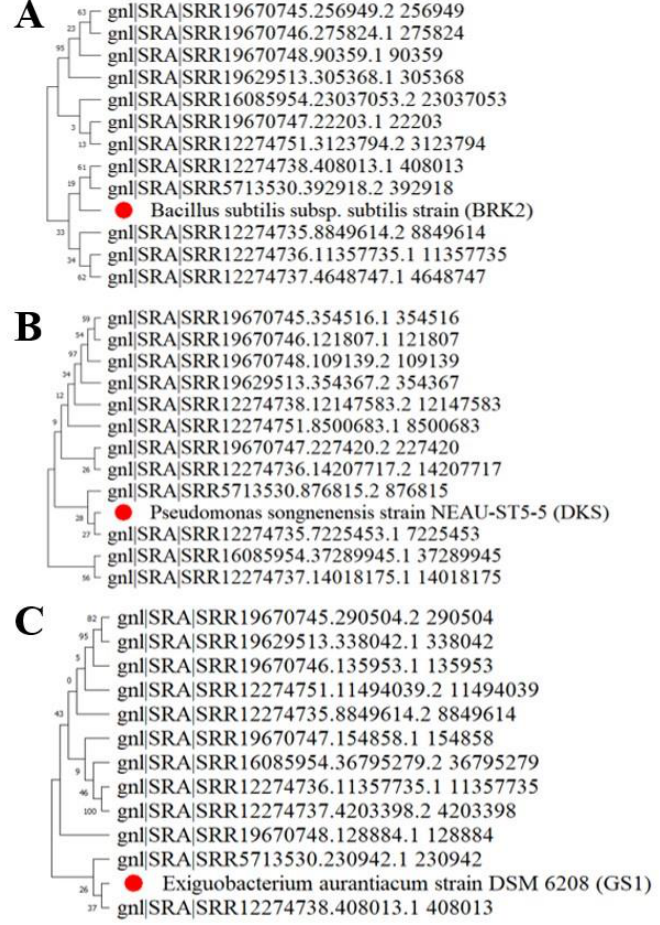
Figure 10. Phylogenetic analysis of Bacillus subtilis ( A ), Pseudomonas songnenensis ( B ), and Exiguobac- terium aurantiacum ( C ) with their twelve different orthologues, isolated from three selected sampling stations (BRK, DKS, and GS) in the HRE.